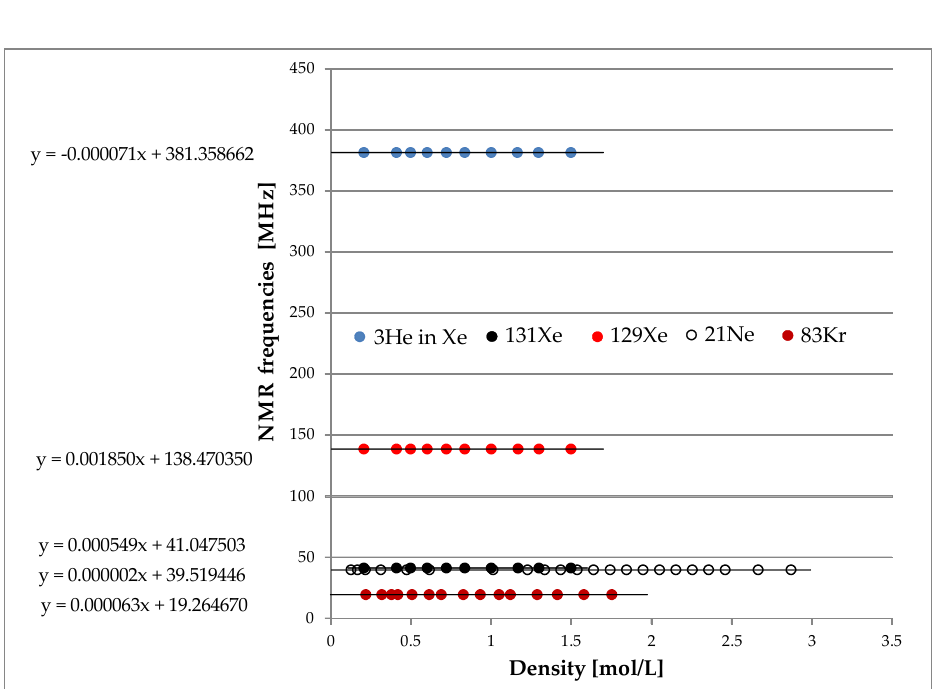
Figure 1. NMR frequency dependences on the density of the gaseous noble gases 3 He (in Xe), 21 Ne, 83 Kr, 129 Xe, and 131 Xe in the magnetic field B 0 = 11.7574 T.